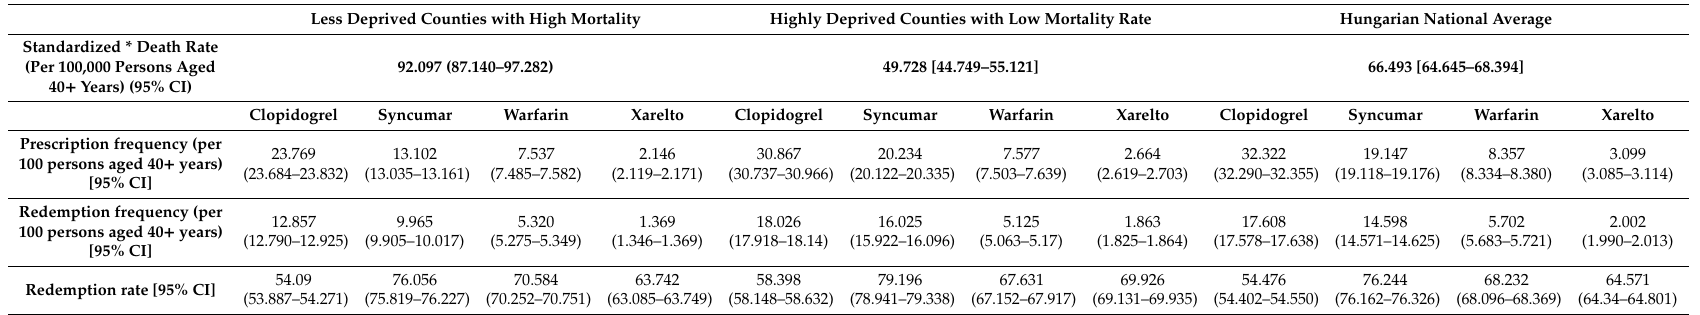
Table 4. Mortality rate of the population aged 40 + years to thromboembolic diseases and frequency of the prescription and redemption, as well as redemption rate of oral antithrombotic drugs in the less deprived counties with high mortality (bordered by a red line on Figure 1) of the northwestern part of Hungary and in highly deprived counties with a low mortality rate (bordered by a green line on Figure 1) of the eastern part of Hungary in comparison with the national average data,